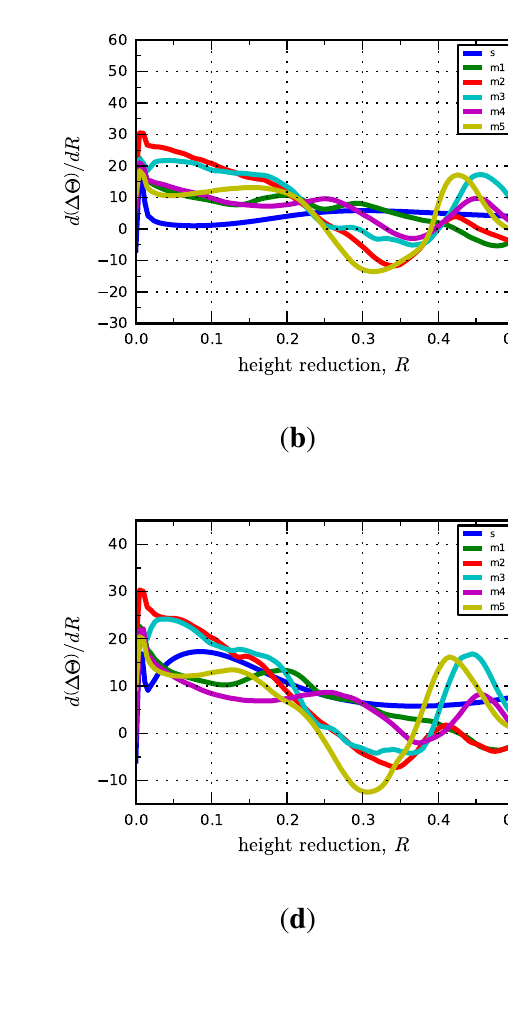
phase in the C-I interface; ( b ) niobium phase in the C-I interface; ( c ) copper phase in the D-I interface; and ( d ) niobium phase in the D-I interface. In the legend, “s” refers to the periodic bicrystal simulations and the “m1, m2, ...” refer to the different realizations of the multicrystal